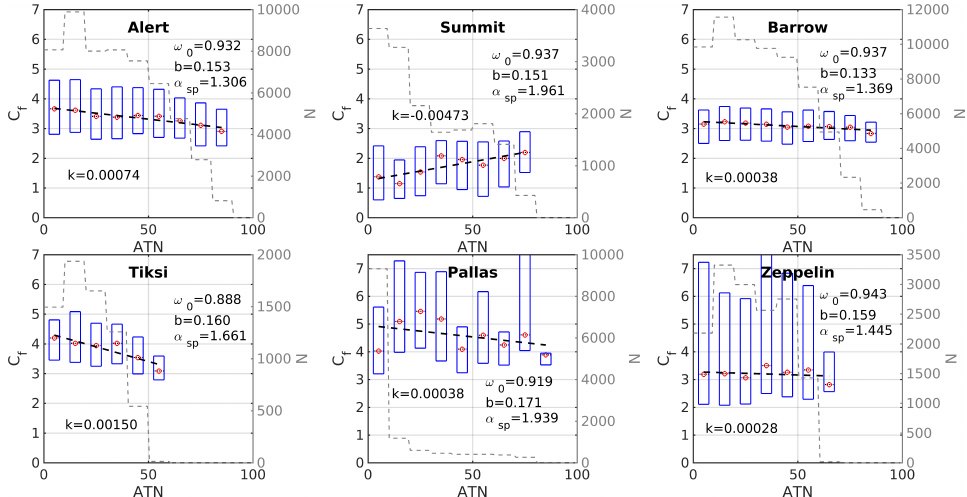
Figure 8. Correction factor ( C f ) as a function of filter attenuation (ATN) calculated using Eq. (3). The grey dashed line and the right hand y axis show the number of data points that each ATN range comprise. The blue boxes represent the 25th to 75th percentile range, whereas the red circles represent the median values. C f values in the figure are for all available wavelengths. The figure also shows the median single- scattering albedo ( ω 0 ) , back-scatter fraction ( b) , and scattering Ångström exponents ( α sp ) . The ω 0 of the aerosol was calculated using the = σ ap /σ = 1 + k · ATN. absorption coefficients from Fig. 6. The slope of the ATN dependence is shown as the value k so that C − 1 0 f Table 5. Aethalometer correction factors ( C f ) for the different stations. The values were calculated using averaging-time-weighted percentiles because of the adaptive average time used to derive them. The top portion of the table reports the C f values for all available wavelengths of the co-located absorption instruments. Aethalometer wavelengths were interpolated to these co-located absorption photometer wavelengths using absorption Ångström exponents. The Summit AE-16 data were extrapolated to a wavelength of 637nm using α = 0.814. The bottom portion of the table reports the statistics of C f using all available wavelengths. The last row in the table shows the number of data points ( N ) used for the statistics. The overall statistics comprise all stations except the high-altitude station of Summit. Alert Summit Barrow Tiksi Pallas Zeppelin Overall C f for individual wavelengths 467nm 3.43 – 3.17 – – – –